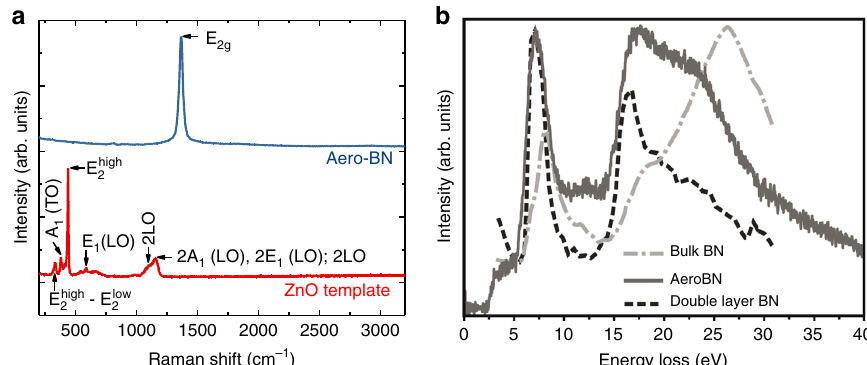
Fig. 3 Raman and EELS characterisation of the Aero-BN network. a Raman spectra of Aero-BN structure (blue) and ZnO template (red). b Low-loss EELS spectra of bulk-hBN 37 (dash-point), Aero-BN (solid), and double layer hBN 37 (dashed). The positions and shapes of the π -plasmon at ~6 eV match. The positions of the σ -plasmon ~15 eV match, while shape and relative intensity differ slightly, whereas no peak ~26 eV (bulk-BN) is seen. Spectra are normalized from the onset of the π -plasmon to its